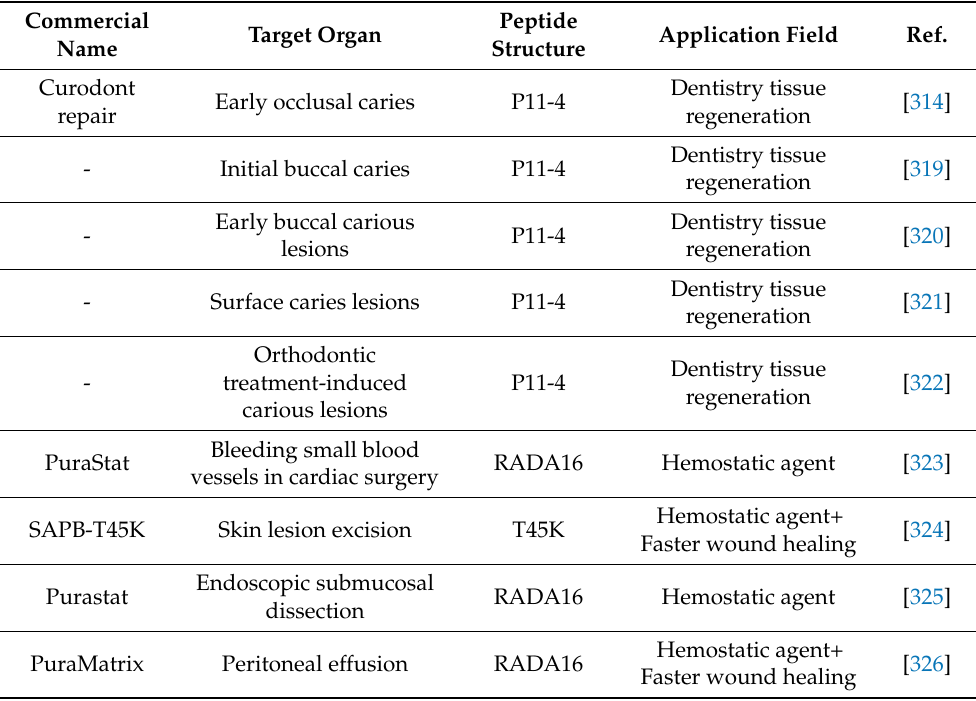
Table 2. A list of the performed works in clinical trials for self-assembled supramolecular pep- tide